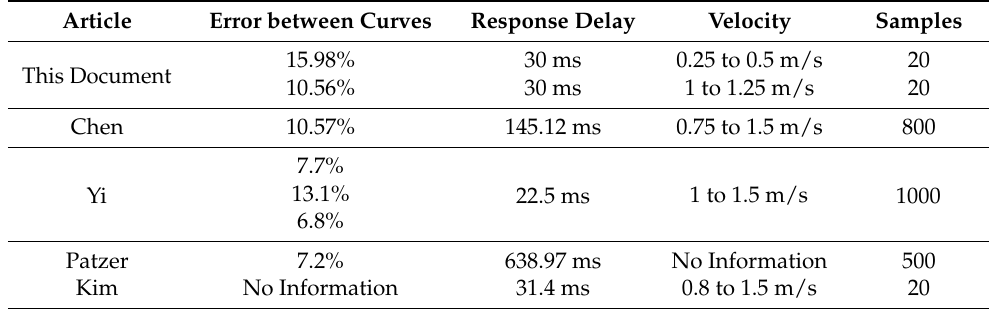
Table 3. Analysis of the